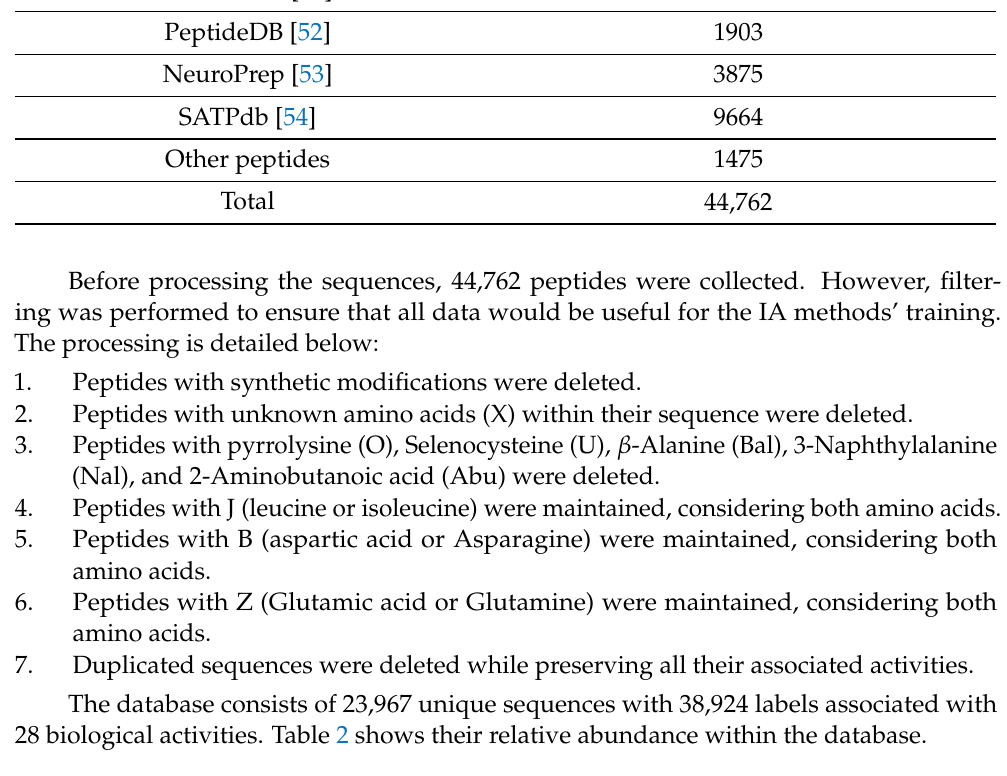
Table 2. Distribution of biological activities of peptides within the